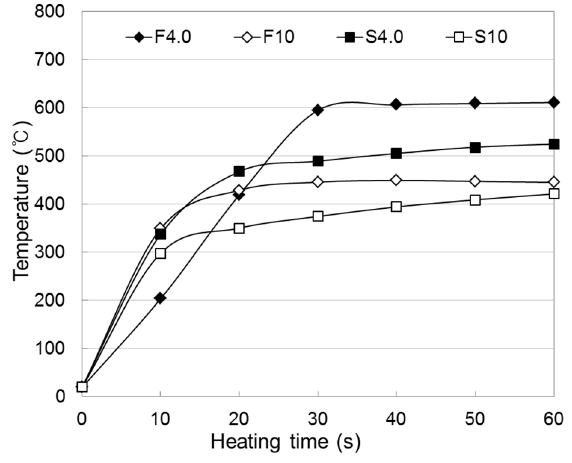
Figure 8. Appearance of heating conductive resistor by induction (metal mesh, 4 kW–2 cm). The thickness of the conductive resistor affected the temperature elevation